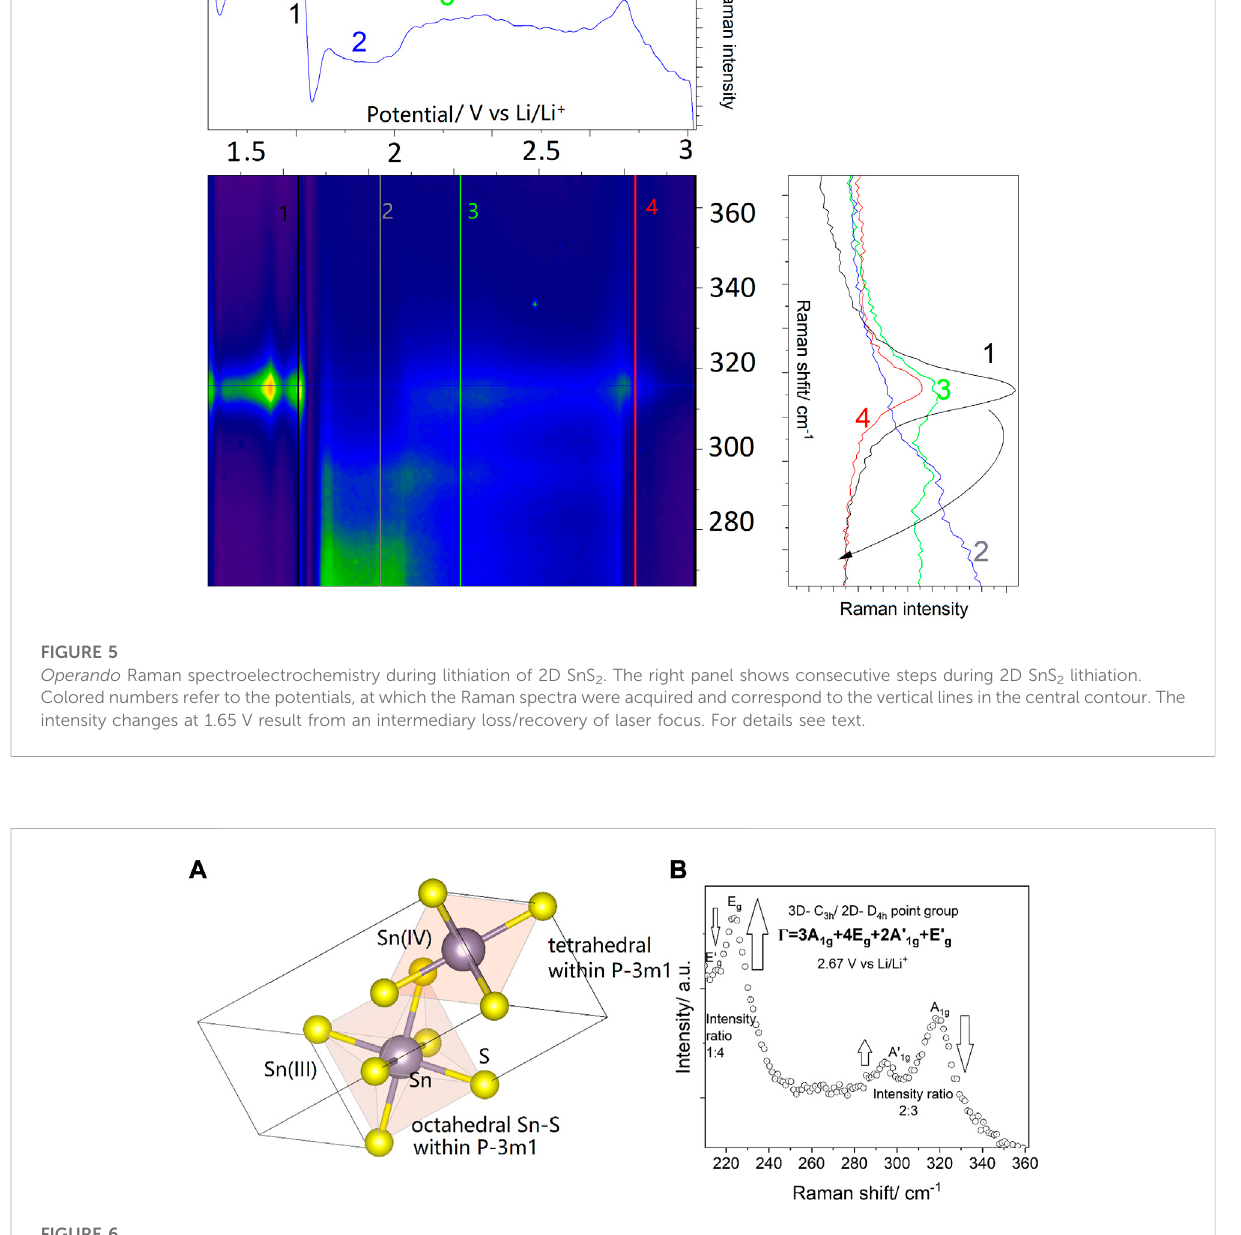
FIGURE 6 (A) ThedoubleoccurrenceofA 1g andE g Raman activemodesisproposed toarisefromC 3h andD 4h symmetrieswithinthe2HpolytypeofSnS 2 , which belongs to the P-3m1 class. (B) In the operando Raman spectrum of the 2D material at 2.67 V vs. Li/Li + , the E g band can be higher in intensity than the A 1g band only in octahedral environment, as it was observed for TMDs with pure octahedral symmetry. Sn(IV) favors tetrahedral symmetry (Gurnani et al., 2017). In tetrahedral symmetry A 1g prevails over other modes. Octahedral symmetry is only possible in Sn(III) environment (Fitzsimmons, 1968) (Beletskiy et al., 2014). On purpose non-background corrected data are shown. For clear prevalence of the modes after subtraction see Supplementary Figure